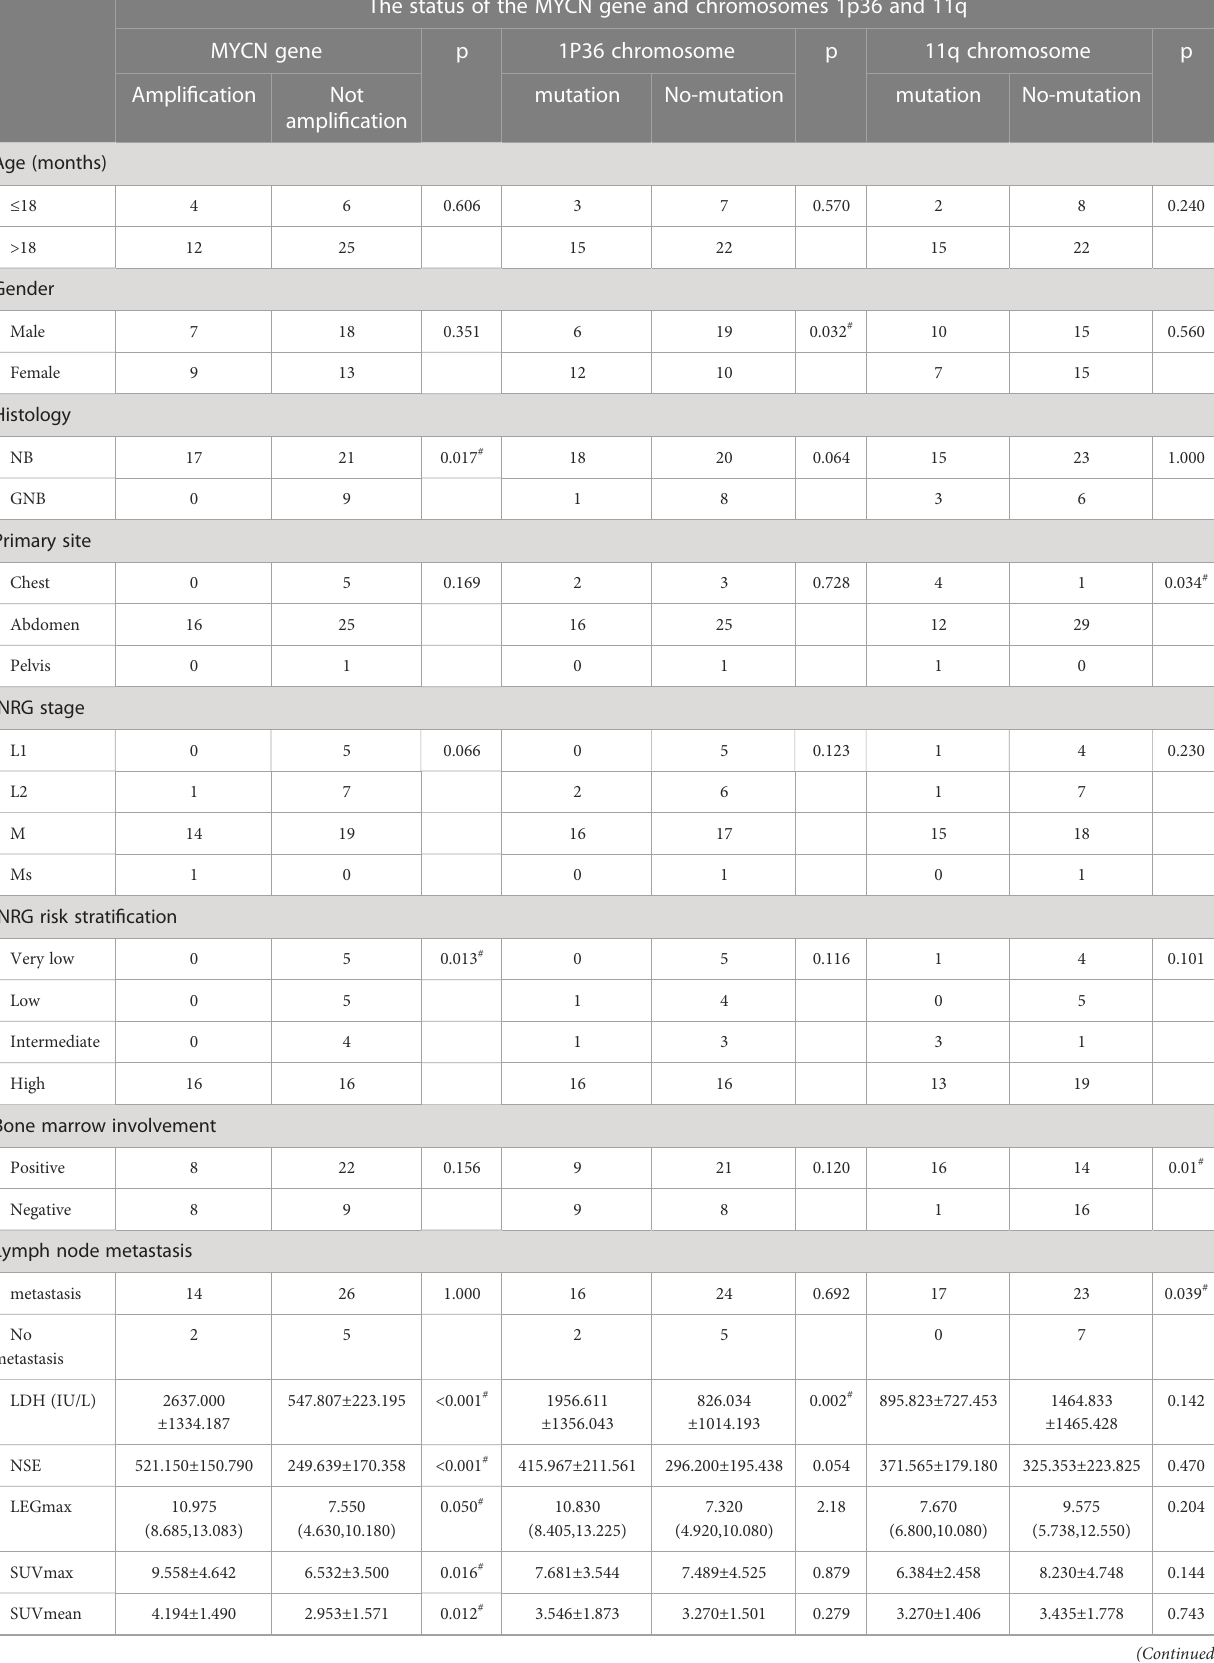
TABLE 2 General characteristics of MYCN gene and chromosomes 1p36 and 11q status. The status of the MYCN gene and chromosomes 1p36 and